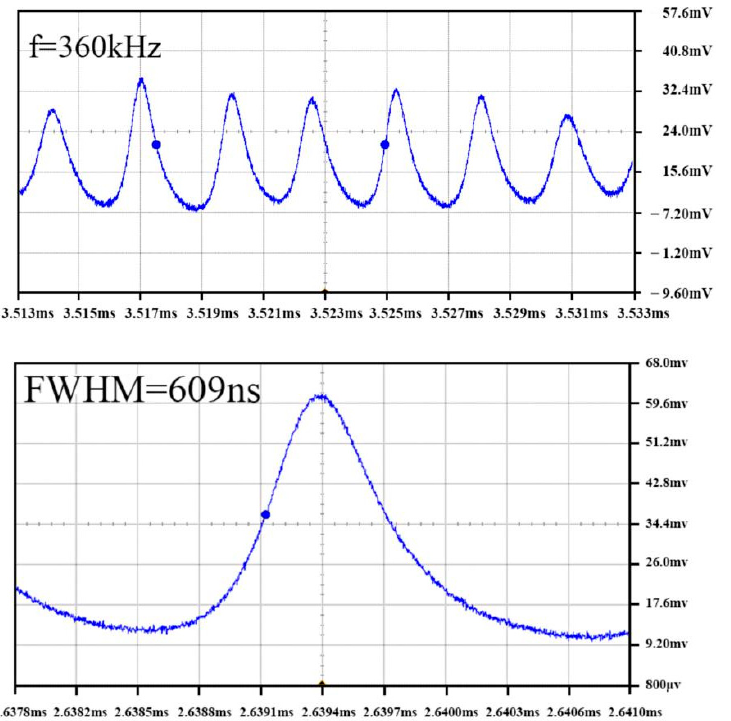
Figure 7. Temporal pulse train and single pulse profile from the β -Ga 2 O 3 -SA Q-switched Nd:GYAP laser.